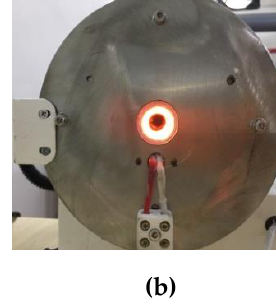
Figure 10. Test rig at 1100 ℃ ; ( a ) sensor position; ( b ) inside the heater.